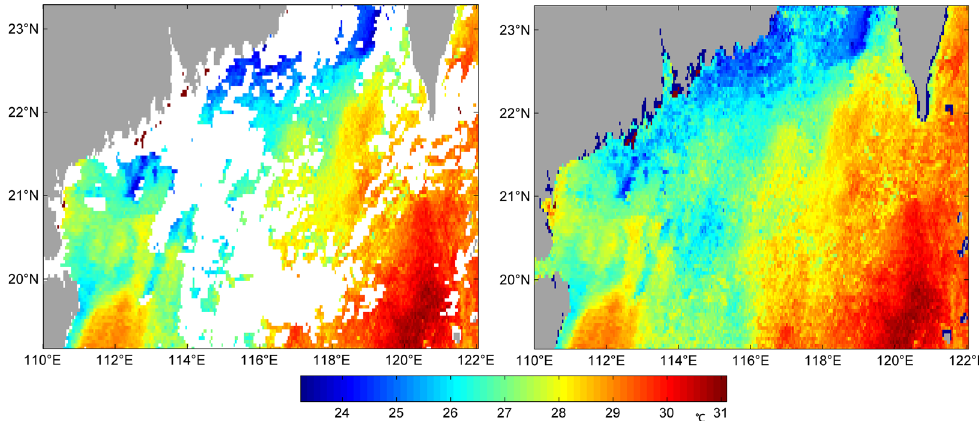
Fig 6. Left panel: original gappy image for 2 nd May, 2012; right panel: its reconstruction